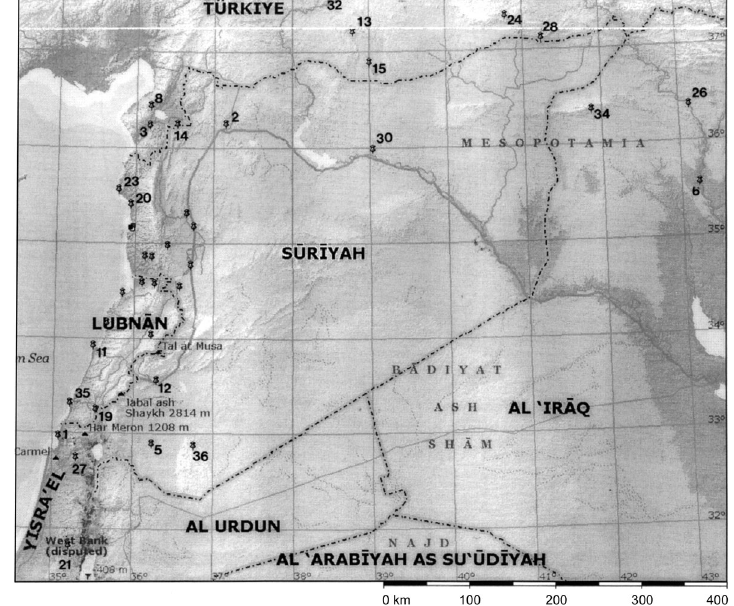
Fig. 5. Location map of the earthquake of 1170. 1 – Acre; 2 – Aleppo; 3 – Antioch; 4 – Arqa; 5 – Ashtera; 6 – Ashur; 7 – Baalbek; 8 – Baghras; 9 – Bannyas; 10 – Barin; 11 – Beirut; 12 – Damascus; 13 – Edessa; 14 – Harim; 16 – Harran Hims; 17 – Hisn Akkar; 18 – Hisn al-Akrad; 19 – Hunain; 20 – Jebeleh; 21 – Jerusalem; 22 – Jubail; 23 – Latakiya; 24 – Mardin; 25 – Margat; 26 – Mosul; 27 – Nazareth; 28 – Nisibis; 29 – Qusayr; 30 – Raqqa; 31 – Safita; 32 – Samosata; 33 – Shaizar; 34 – Sinjar; 35 – Sur; 36 – Tayma; 37 – Hama; 38 – Tripolis; 39 –